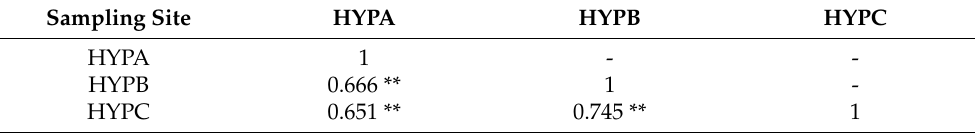
Table 4. Correlation coefficients between the standard chronologies at the sampling points. Sampling